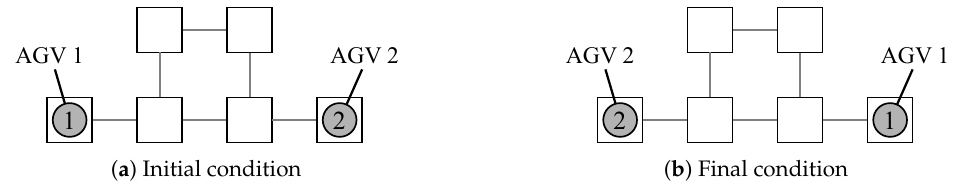
Figure 8. Initial and final condition for a sample route planning problem. Consider the problem of exchanging the positions of AGV1 and